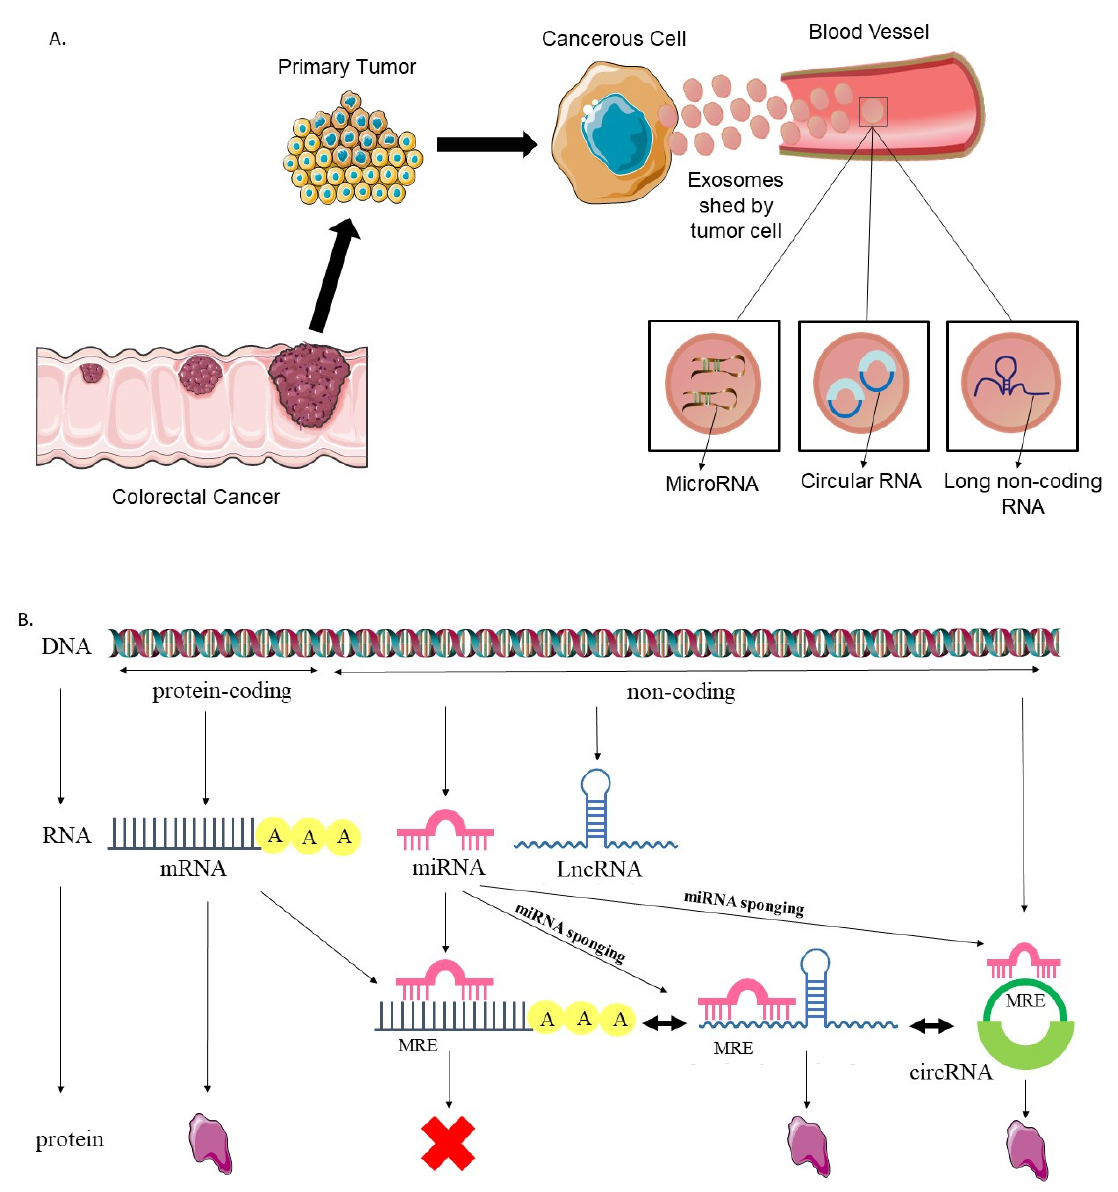
Figure 1. ( A ) Exosomal microRNA, circular RNA, and long non-coding RNAs in liquid biopsies have potential roles for CRC diagnosis, prognosis, and therapy prediction. ( B ) The rationale behind this sponging mechanism lies in the fact that mRNAs, which are produced from protein-coding sections of the genome, are normally translated into proteins. On the other hand, miRNAs, lncRNAs, and circRNAs are transcribed from non-coding DNA. miRNAs are capable of binding to mRNAs by MREs, which can thus prevent them from being translated. Since they also contain MREs, lncRNAs and circRNAs may bind to and sponge miRNAs, causing the previously miRNA-inhibited mRNAs to be translated into